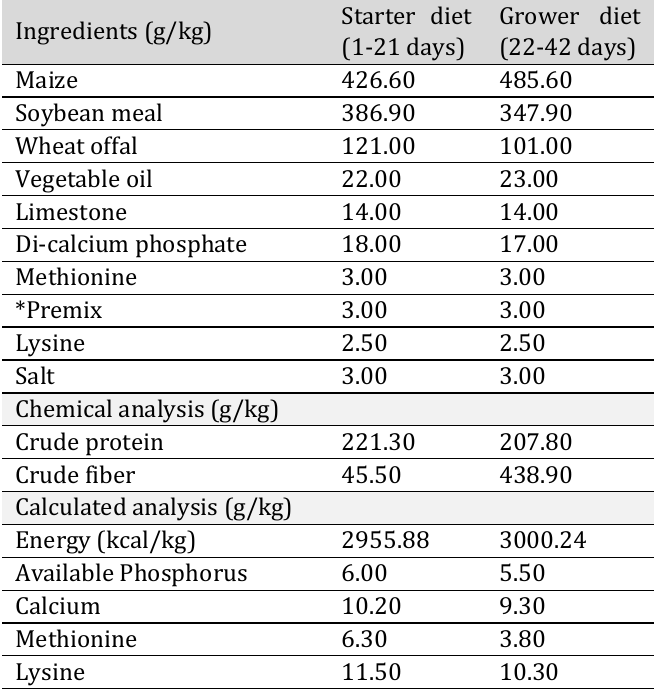
Table 2. Composition and nutrient contents of basic